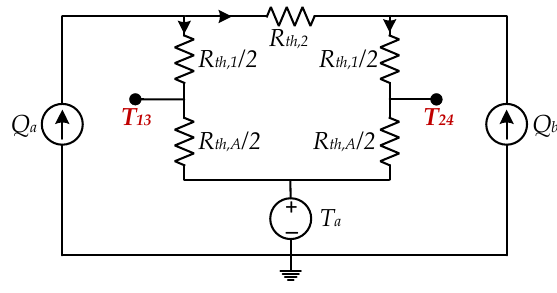
Figure 8. Simplified steady state thermal circuit. Table 4. Model